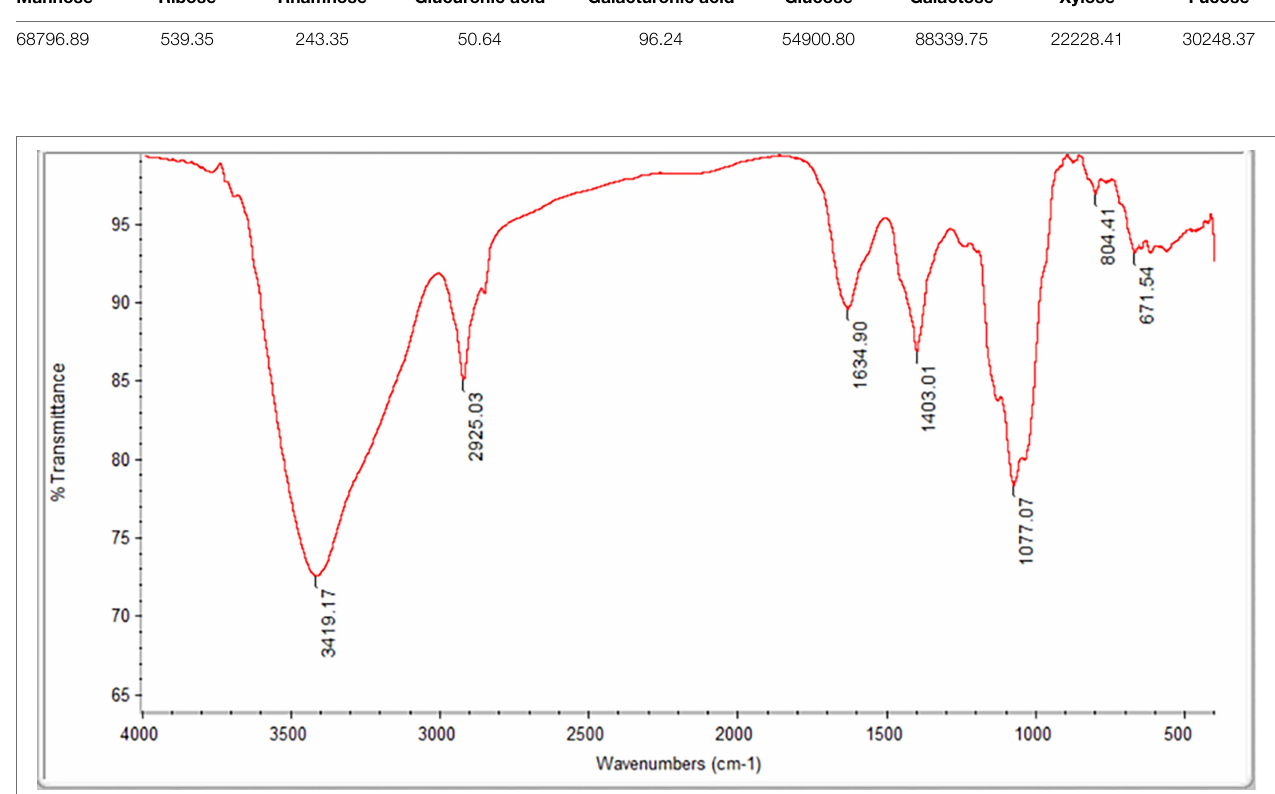
FIGURE 1 | Fourier transform infrared (FT-IR) spectrum of the Flammulina velutipes polysaccharides